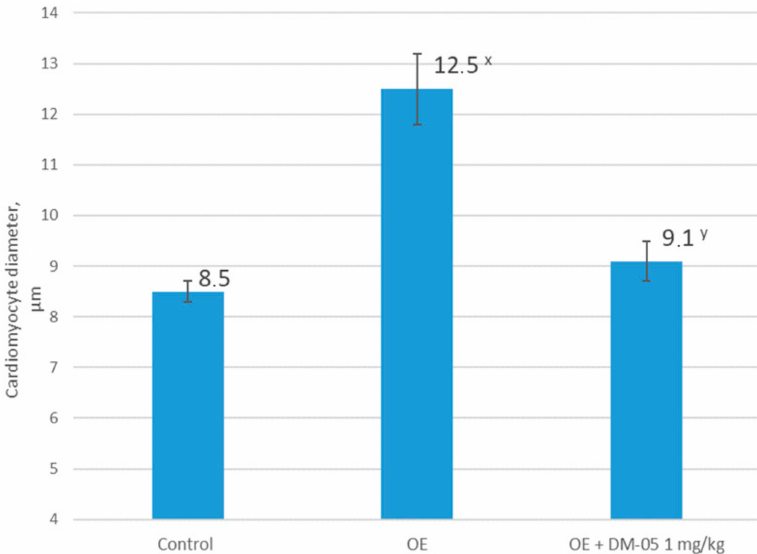
Figure 2. Cardiomyocyte diameter ( µ m) in animal groups with hypoestrogen-induced endothelial dysfunction and its correction by furostanol glycosides from Dioscorea deltoidea cell culture (DM-05) ( n = 10). OE: group with bilateral ovariectomy; OE + DM-05: group with bilateral ovariectomy treated with DM-05 at a dose of 1 mg / kg; x p < 0.05 compared to the control; y p < 0.05 compared to the group with